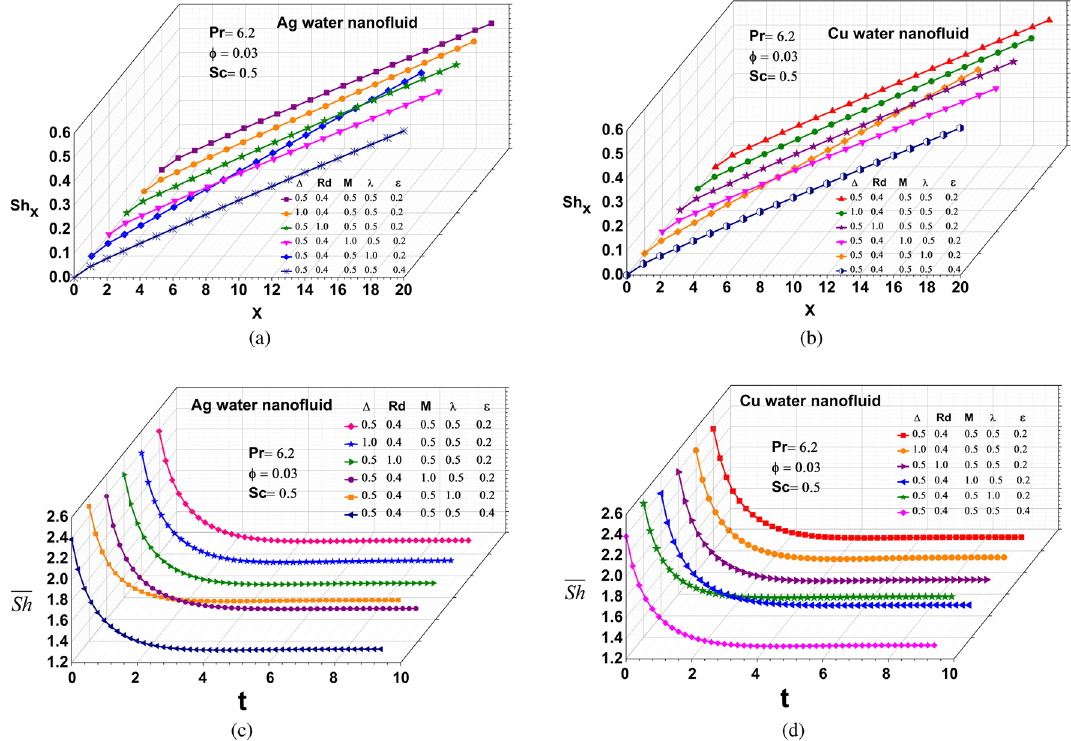
Figure 7. Local Sherwood number: ( a ) Silver ( b ) Copper, Average Sherwood number: ( c ) Silver ( d )